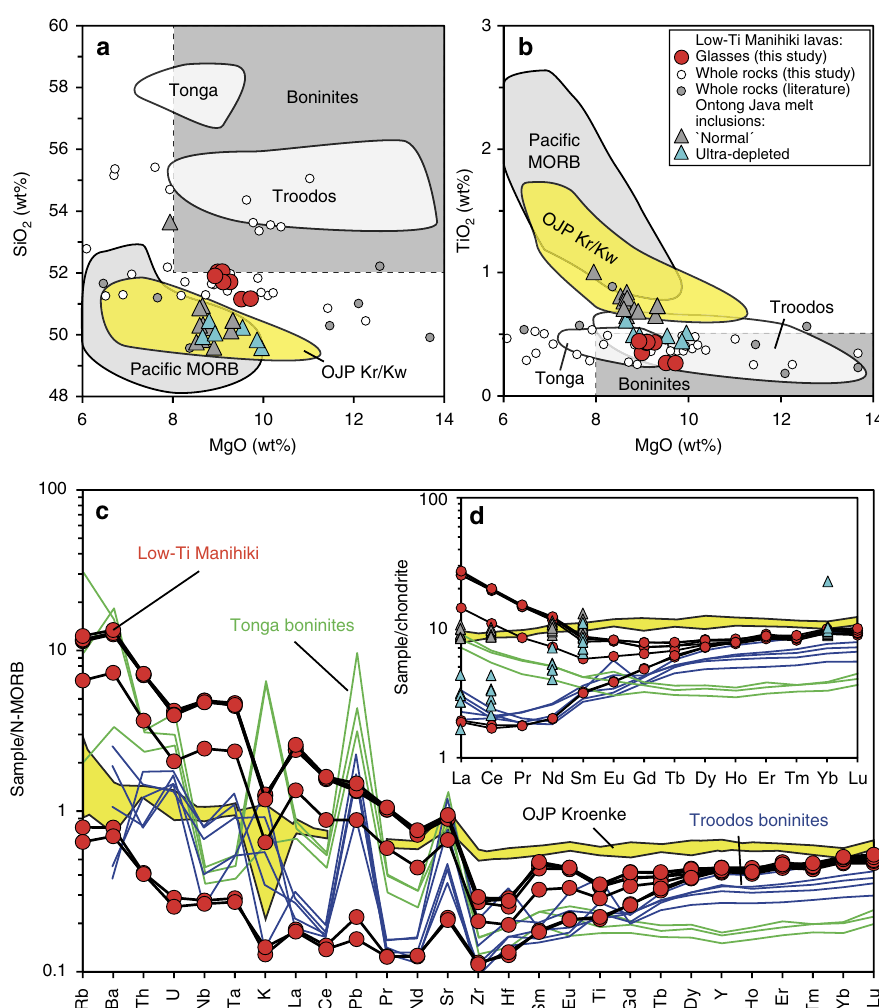
Figure 2 | Selected major oxide and incompatible element compositions of low-Ti Manihiki rocks and glasses. ( a ) MgO versus SiO 2 and ( b ) MgO versus TiO 2 plots for low-Ti Manihiki glasses (red circles) and whole rock samples (white circles: this study, Supplementary Table 2; grey circles: data from refs 4,13). All major element oxide data were normalized on a volatile-free basis to 100%. Compositional fields for Tonga and Troodos boninites 26,27 , Kroenke/Kwaimbaita OJP rocks and glasses 6,15 , melt inclusions from Ontong Java 16 and Pacific MORB 66 are shown for reference. Compositional range of boninites ( 4 52 wt% SiO 2 , 4 8 wt% MgO and o 0.5 wt% TiO 2 ) is shown by grey field with dashed outer line 14 . ( c ) Incompatible element contents in low- Ti Manihiki glasses (black patterns), high-Ca boninites from Tonga (green patterns) and Troodos (blue patterns) normalized to N-MORB. ( d ) Rare earth elements in the same samples normalized to chondritic abundances. Most low-Ti glass samples from Manihiki have U-shaped patterns similar to boninites, reflecting in part re-enrichment of the most incompatible elements in a depleted source. Direct comparison of incompatible elements shows that boninite- like low-Ti Manihiki glasses do not show enrichment in fluid-mobile elements or negative Nb-Ta anomalies characteristic of boninites. Representative compositions for Troodos and Tonga boninites 67,68 and OJP Kroenke-type rocks (OJP Kroenke; yellow field) 6 are also shown. OJP inclusions 16 in d have similar labelling as in a , b . N-MORB and chondrite compositions for normalization are from ref.